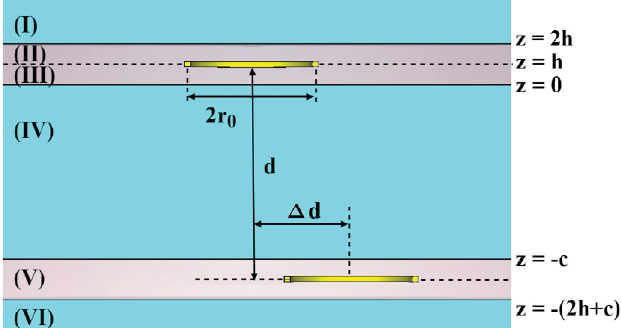
Fig. 2. Theoretical model of two insulated coils in a conductive medium where the fi nite size dielectric enclosures for coil insulation of the actual con fi guration are considered as in fi nite